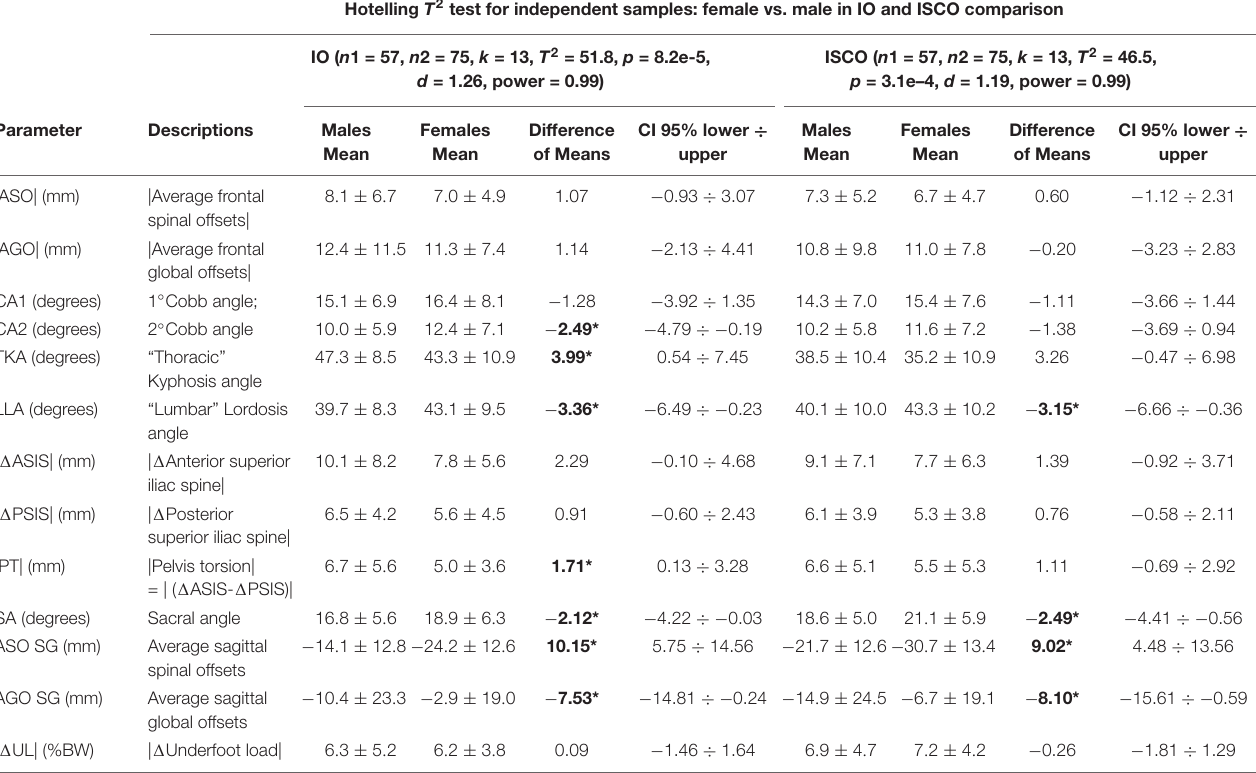
TABLE 3 | AIS patients female vs. male comparisons in both IO and ISCO: Hotelling T 2 tests results, 95% confidence intervals, and difference of means. Hotelling T 2 test for independent samples: female vs. male in IO and ISCO